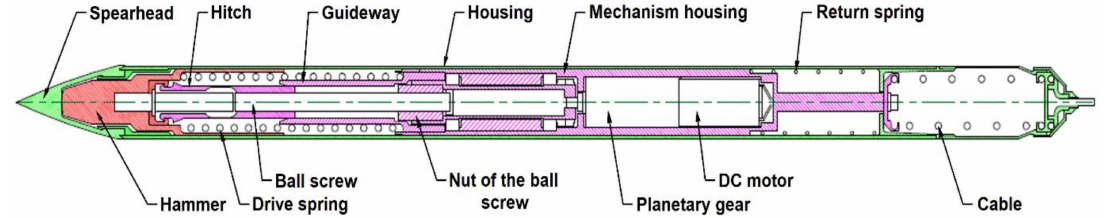
Figure 4. Cross-sectional view of the KRET penetrator developed by the Astronika Sp. z o.o. and the Warsaw University of Technology Team.